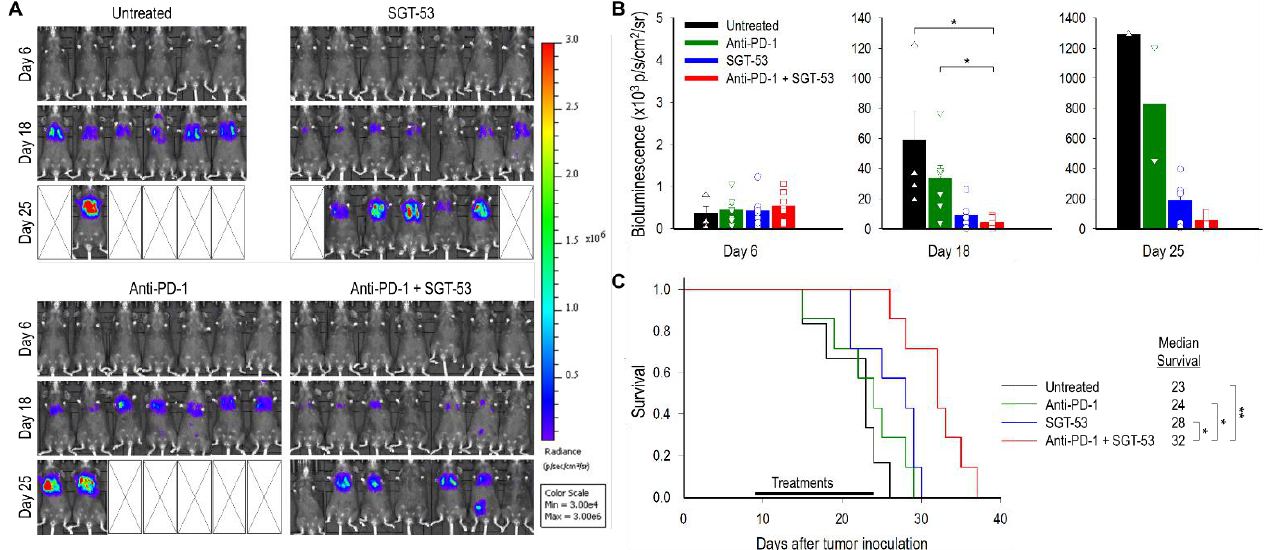
Figure 2. SGT-53 enhances the efficacy of anti-PD-1 therapy in a metastatic LL/2-luc tumor model. ( A ) Bioluminescence images (BLI) of metastatic lung cancer are shown. Bioluminescence signals, shown in a color map, correlate with tumor sizes. Red color: stronger signal, violet color: weaker signal. ( B ) Bioluminescence intensities of tumors were plotted. Circles, squares, and triangles indicate individual mouse. Data are presented as mean ± SEM and were analyzed by Student’s t test. * p < 0.05. ( C ) Kaplan – Meier survival curves of mice. Log-Rank test, * p < 0.05, ** p < 0.001. n = 6 – 7/group.